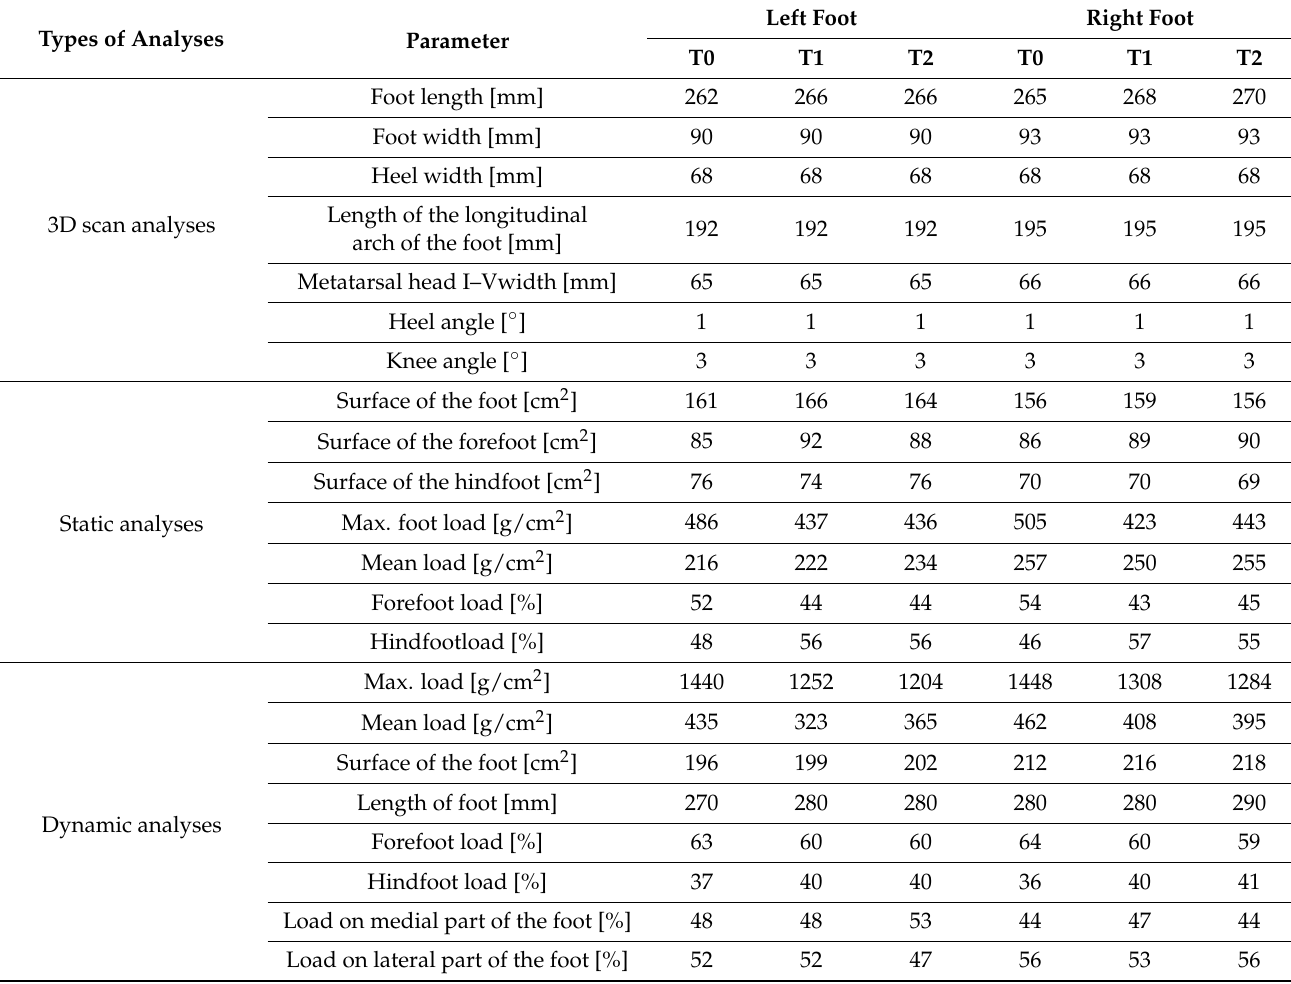
Table 1. Selected anthropometric, static and dynamic foot parameters taken before using the Kinesiology Taping (T0), directly after application of the tapes (T1) and after tapes removal following monthly using (T2).